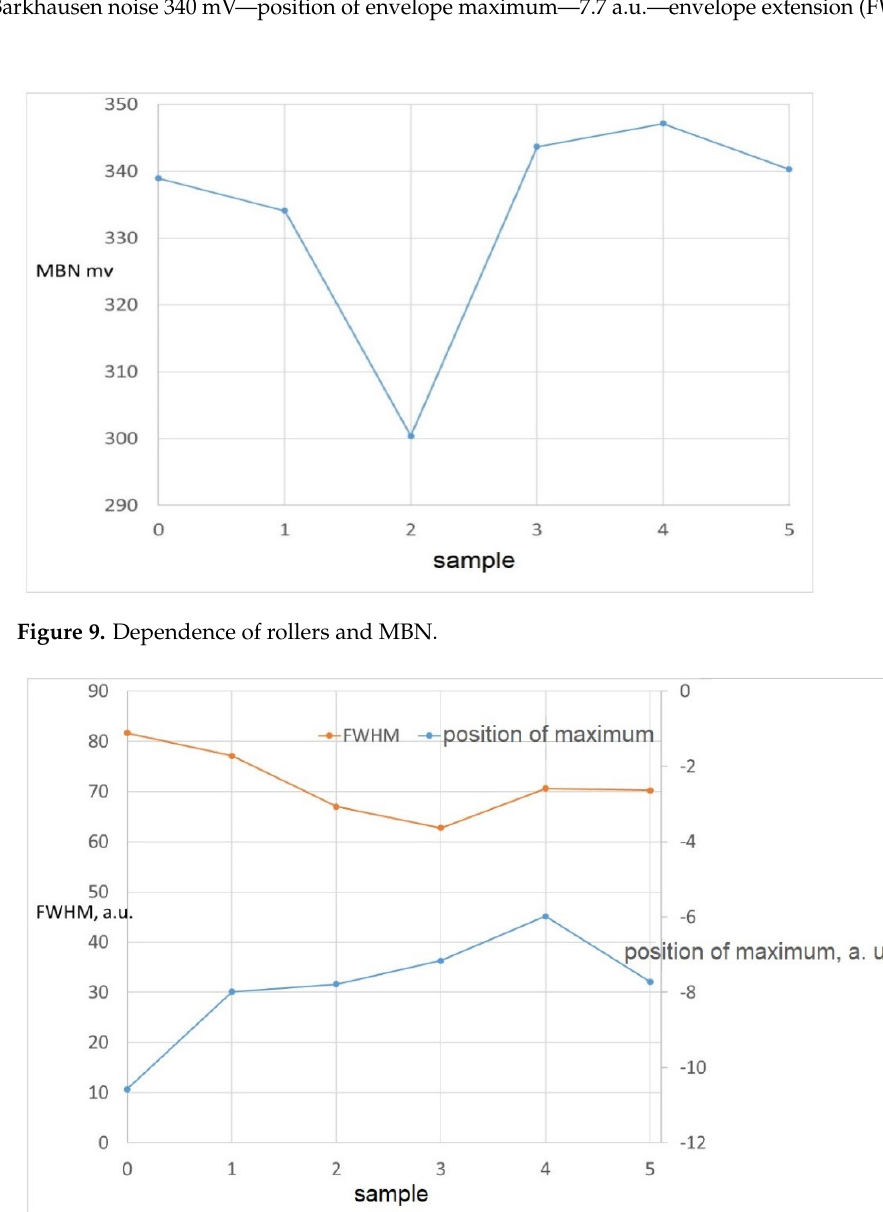
Figure 10. Dependence of rollers and position of maximum and FWHM.